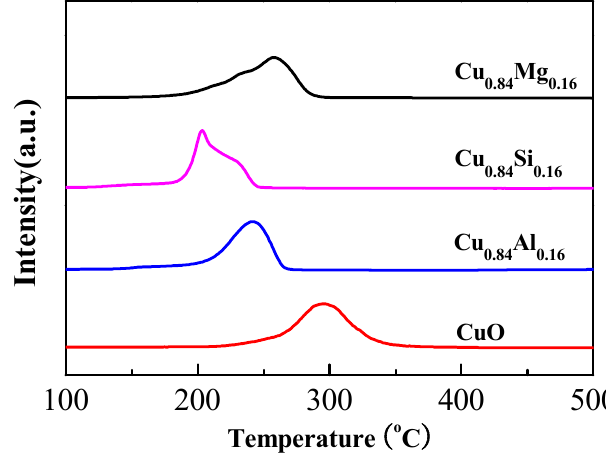
Figure 4. H 2 - temperature-programmed reduction (TPR) profiles of the catalysts.